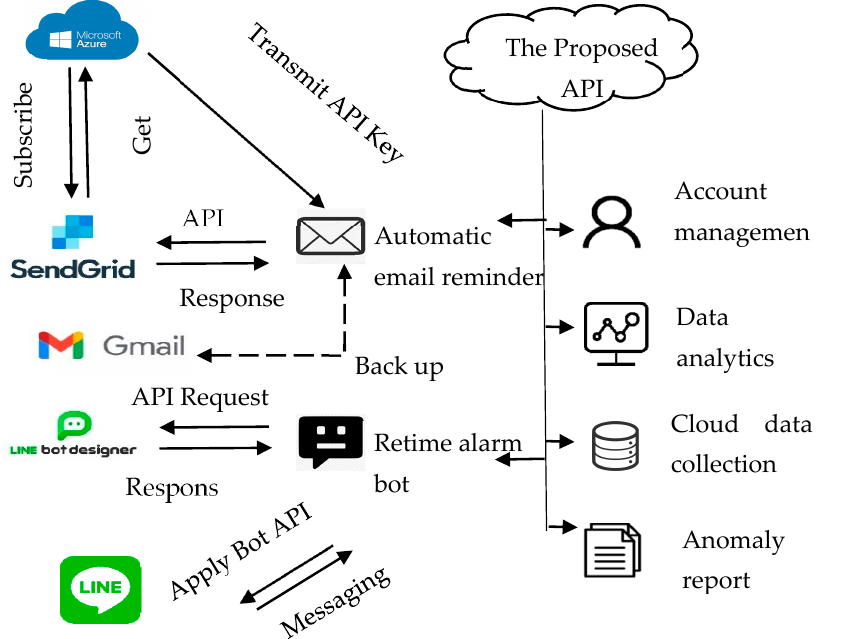
Figure 10. Architecture of automatically generated reports and reminders via API.